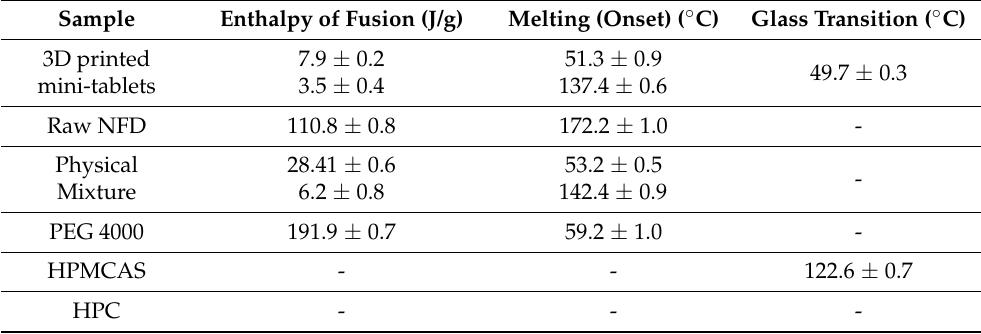
Table 1. Enthalpy of fusion, melting events, and glass transition for NFD 3D printed mini-tablets, and unprocessed materials and physical mixture.